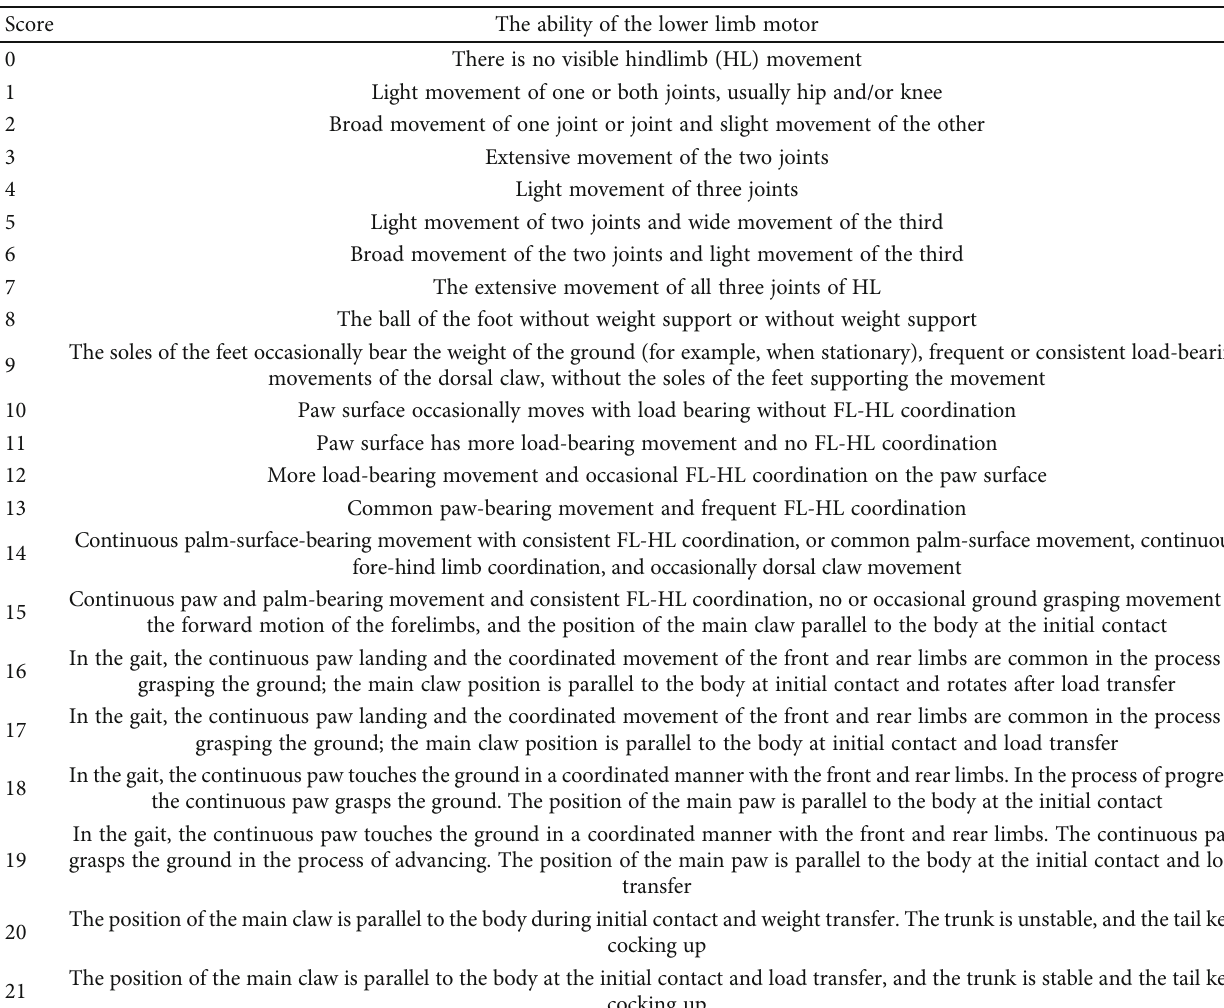
Table 1: Basso-Beattie-Bresnahan locomotor rating